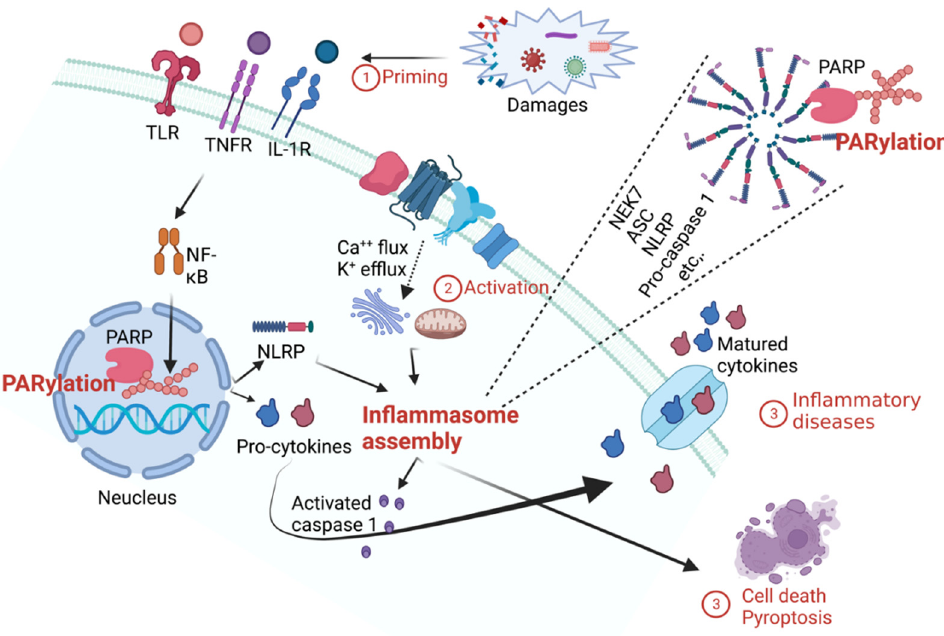
Figure 2. Schematic diagram of the relationships between PARylation and the inflammasome. PARylation is primed by damage signals, such as microbial molecules or endogenous cytokines, and induces the expression of NLRP and pro-cytokines through activation of the transcription factor NF- κ B. PARylation of NF- κ B regulates nuclear retention; in addition, PARylation may regulate the expression of inflammatory genes and the inflammatory process. During the inflammasome activation phase, mitochondrial dysfunction is induced by Ca ++ signaling and is involved in inflammasome assembly with K + efflux. It positively regulates NLRP inflammasome formation via NLRP PARylation. These processes produce pro-inflammatory cytokines that lead to cell death and inflammatory diseases. TLR, toll-like receptor; TNFR, tumor necrosis factor receptor; IL-1R, interleukin 1 receptor; NF- κ B, nuclear factor kappa B; NLRP, nucleotide-binding oligomerization domain, leucine-rich repeat and pyrin domain-containing protein; NEK7, NIMA related kinase 7; ACS, apoptosis-associated speck-like protein containing a CARD. This figure was created using BioRender.